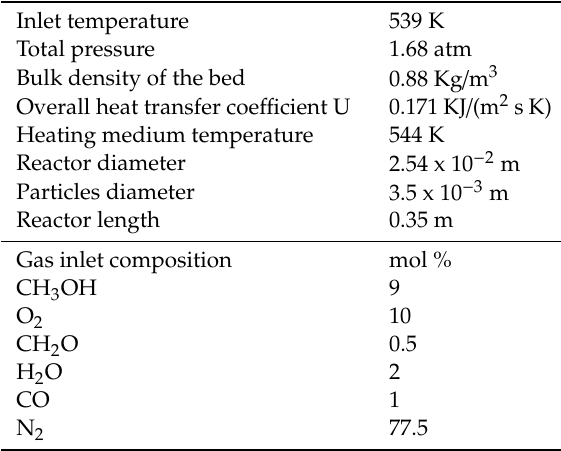
Table 5. Reactor characteristic and operating